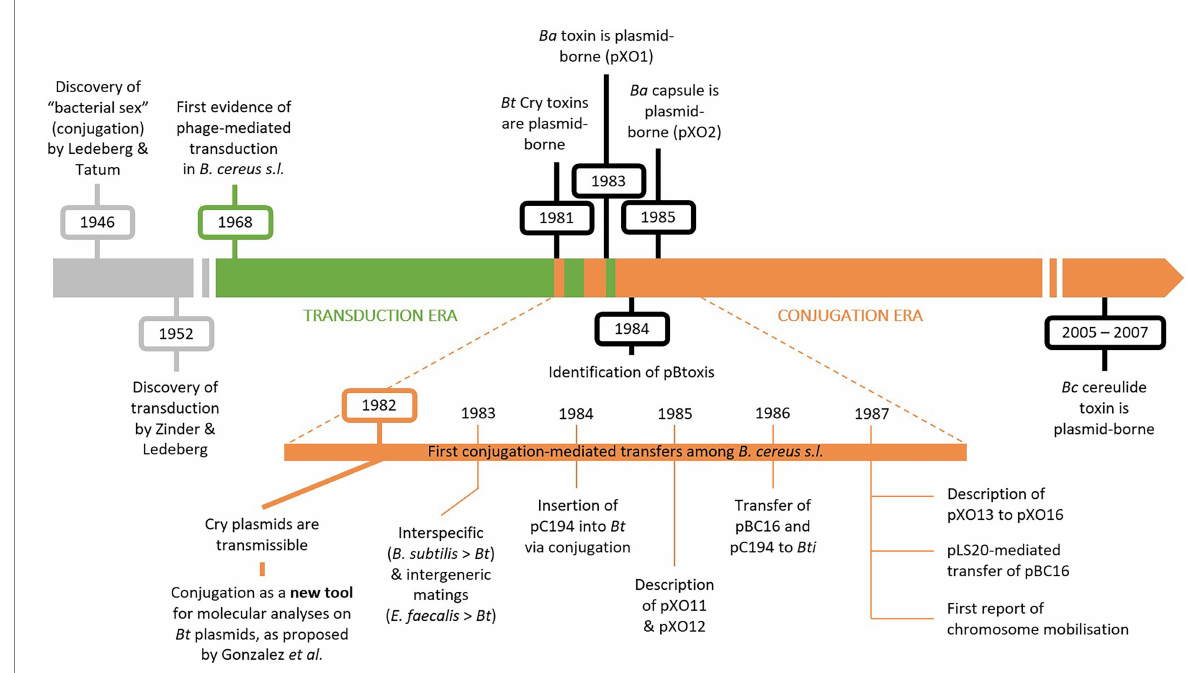
FIGURE 1 Timeline displaying milestones in Bacillus cereus s.l . molecular research. In the 1960’s and 1970’s, molecular research in B. cereus s.l. was mostly conducted using phage-mediated transduction (“transduction era” in green). Since the discovery of conjugative transfer in B. cereus s.l. , plasmid- mediated conjugation became the prevalent technique (“conjugation era” in orange). Plasmid-borne toxins play a key role in B. cereus s.l. taxonomy and were mostly identified alongside conjugation (in black). The historical discovery of conjugation and transduction are depicted in grey. Ba , B. anthracis ; Bt , B. thuringiensis ; Bc , B. cereus ; Bti , B. thuringiensis sv.